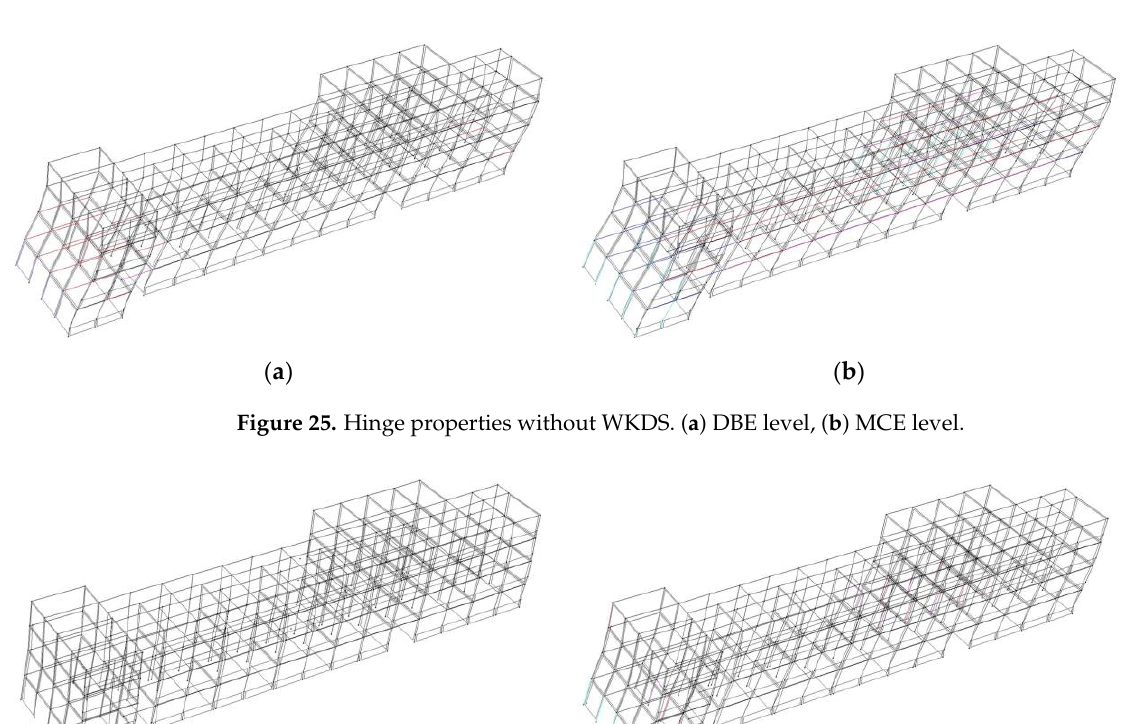
Figure 27. Hysteretic curves of the WKDS (El-Centro EW, 1F).